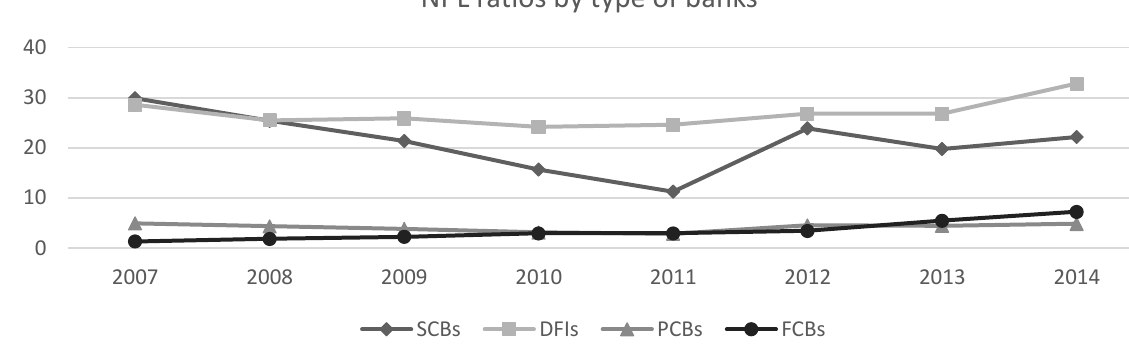
Figure 7. Comparative position of NPL ratios by type of